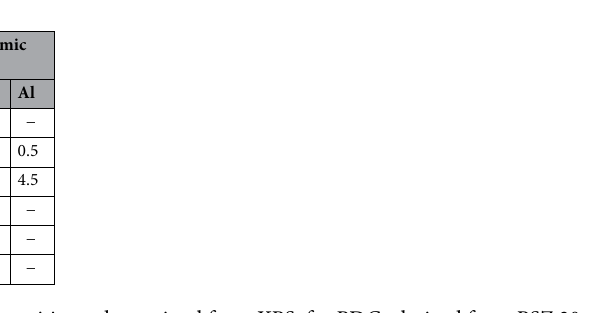
Table 1. Comparison of the elemental compositions, determined from XPS, for PDCs derived from PSZ 20 with and without